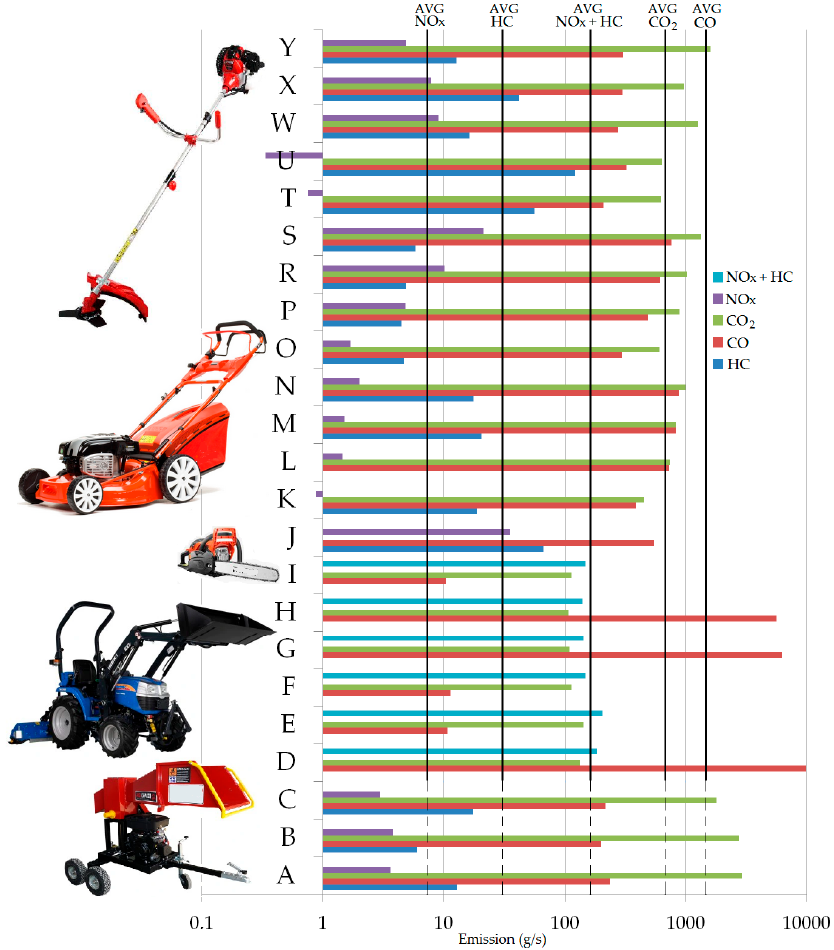
Figure 15. Emissions of pollutants during the operation of machines used for agricultural, horticultural, or fruit farming work in urbanized areas, where: 9.5 kW cylindrical chipper: A: Carburettor fuel supply system; B: Injector fuel supply system; C: Injector fuel supply system equipped with an adaptive drive control system; tractor with a combustion engine (33.6 kW): D: weed spraying, E: tree spraying, F: recultivating greenery; tractor with a hybrid drive (33.6 kW): G: spraying weeds, H: spraying trees, I: recultivating greenery [57]; J: gasoline sawing machine (2.5 kW) working at full power [83]; grass mower: K, L, M, N—with 2 stroke engine, O, P, R, S—with 4 stroke engine [56]; gasoline